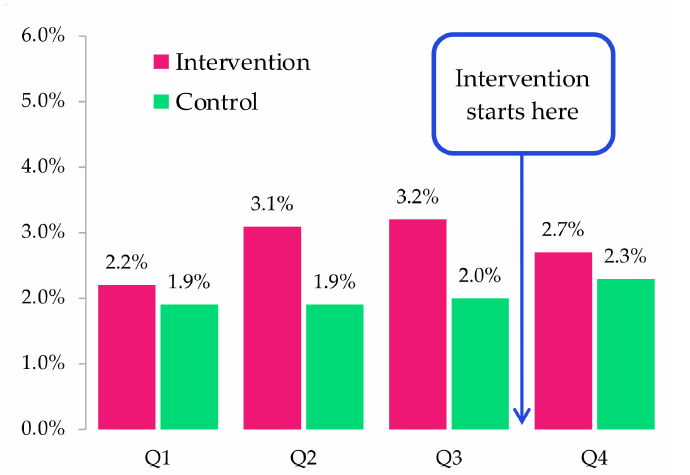
Figure 2. Average number of visits missed by ≥ 7-day per patient in 2022 by intervention OI/ART and